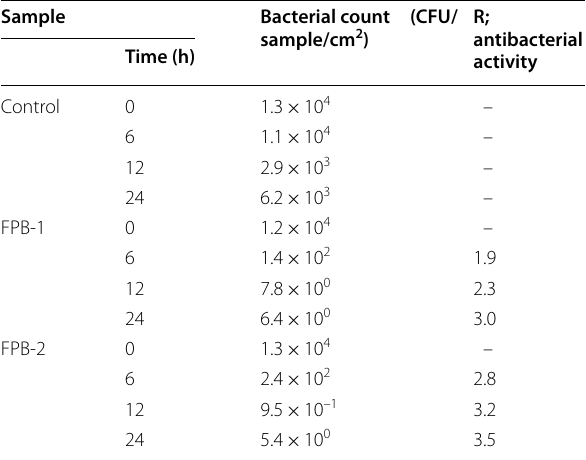
Table 1 Roughness of FPB-treated surfaces